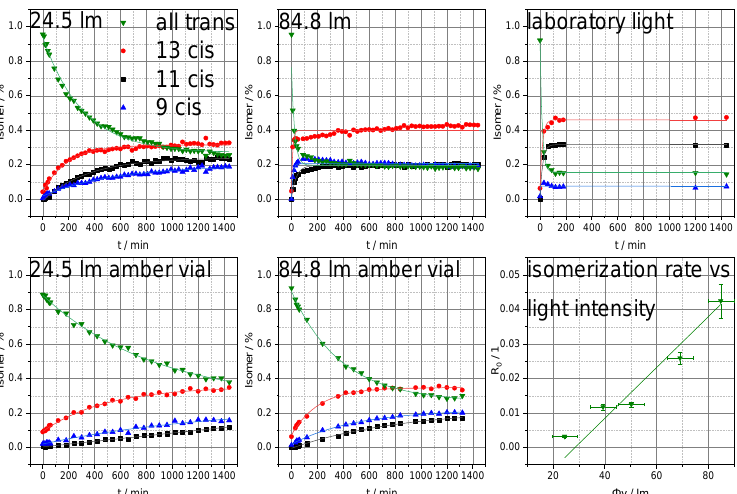
Figure 3. Isomer profiles of retinoic acid at various light intensities and in two different vials, measured at various time points. Additionally, the isomerization rate as a function of light intensity is displayed (error bars represent deviations in light intensity of the LED and isomerization rate).